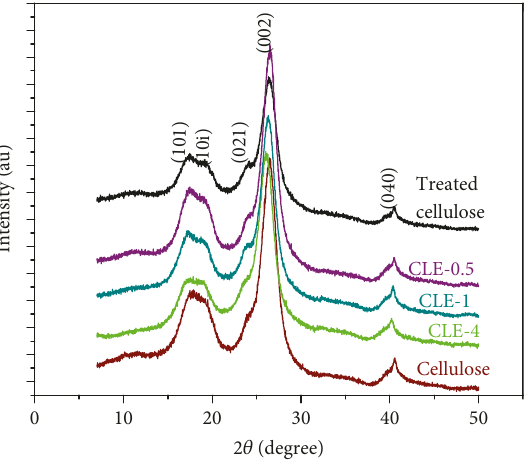
Figure 3: XRD patterns of cellulose and its cross-linked